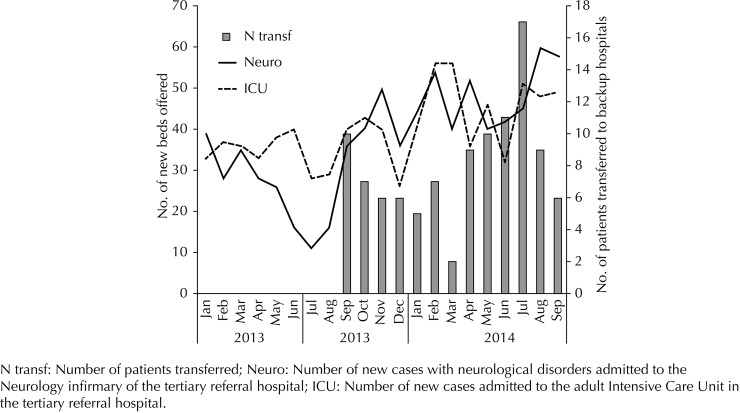
Number of new beds offered in Intensive Therapy and Neurology (Lines - Y Axis to the left) by the tertiary institution according to the number of patients transferred to long-stay hospitals (Columns - Y Axis to the right) versus time (X Axis). The unfilled arrow marks the beginning of Stage 1 of the project and the filled arrow marks the beginning of Stage 2.